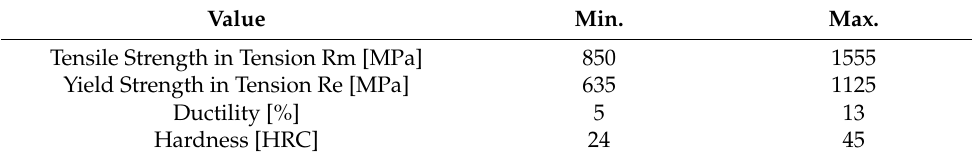
Table 2. Mechanical properties of steel AMS6415 [33,34].